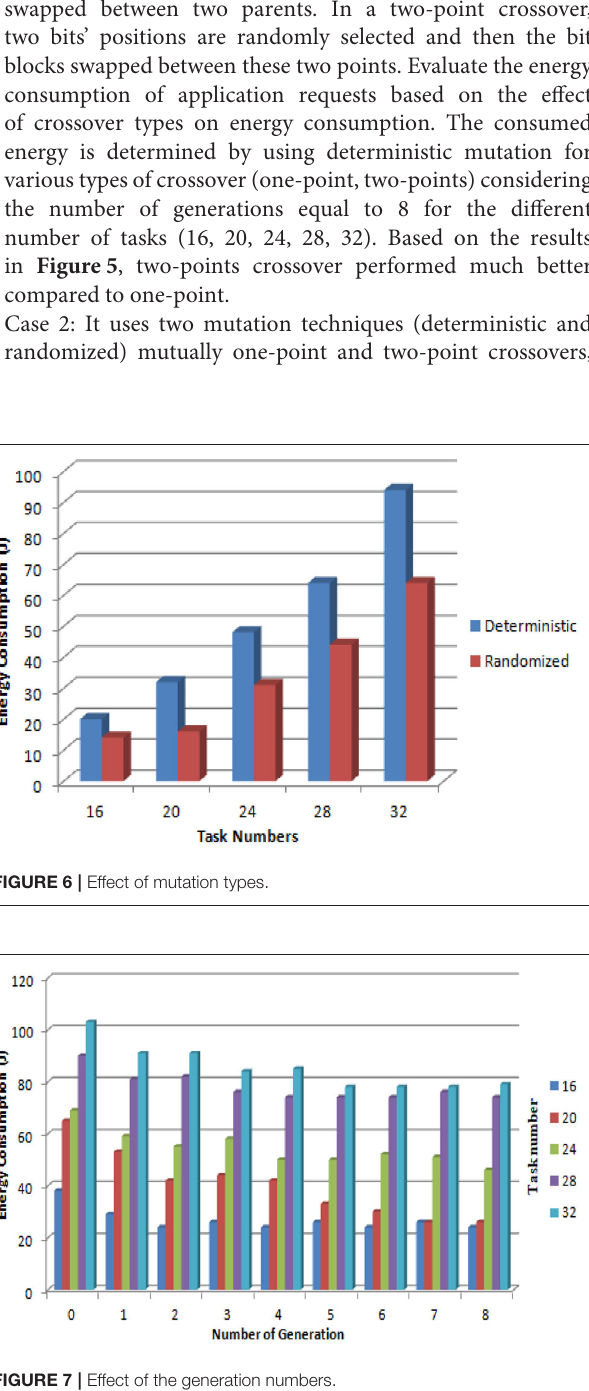
FIGURE 7 | Effect of the generation